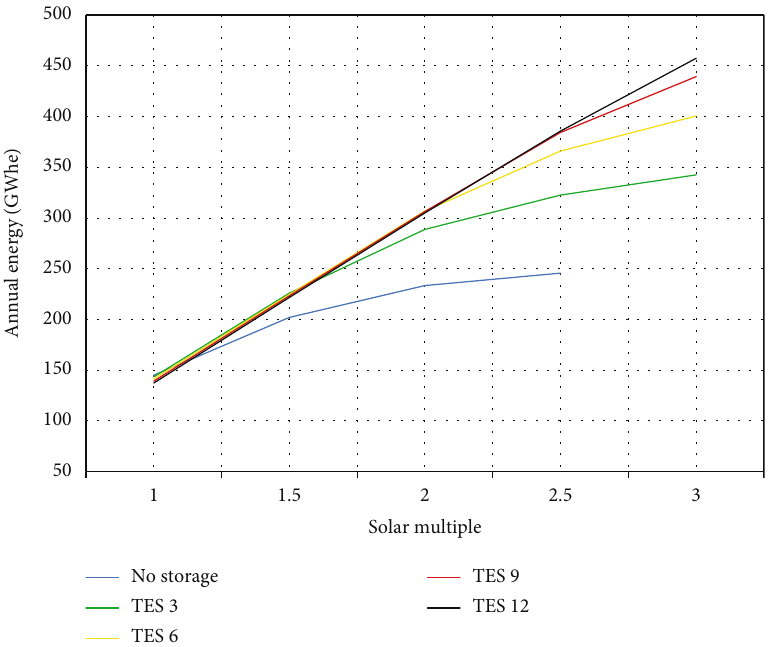
Figure 5: Annual energy generation for varying SM and hours of